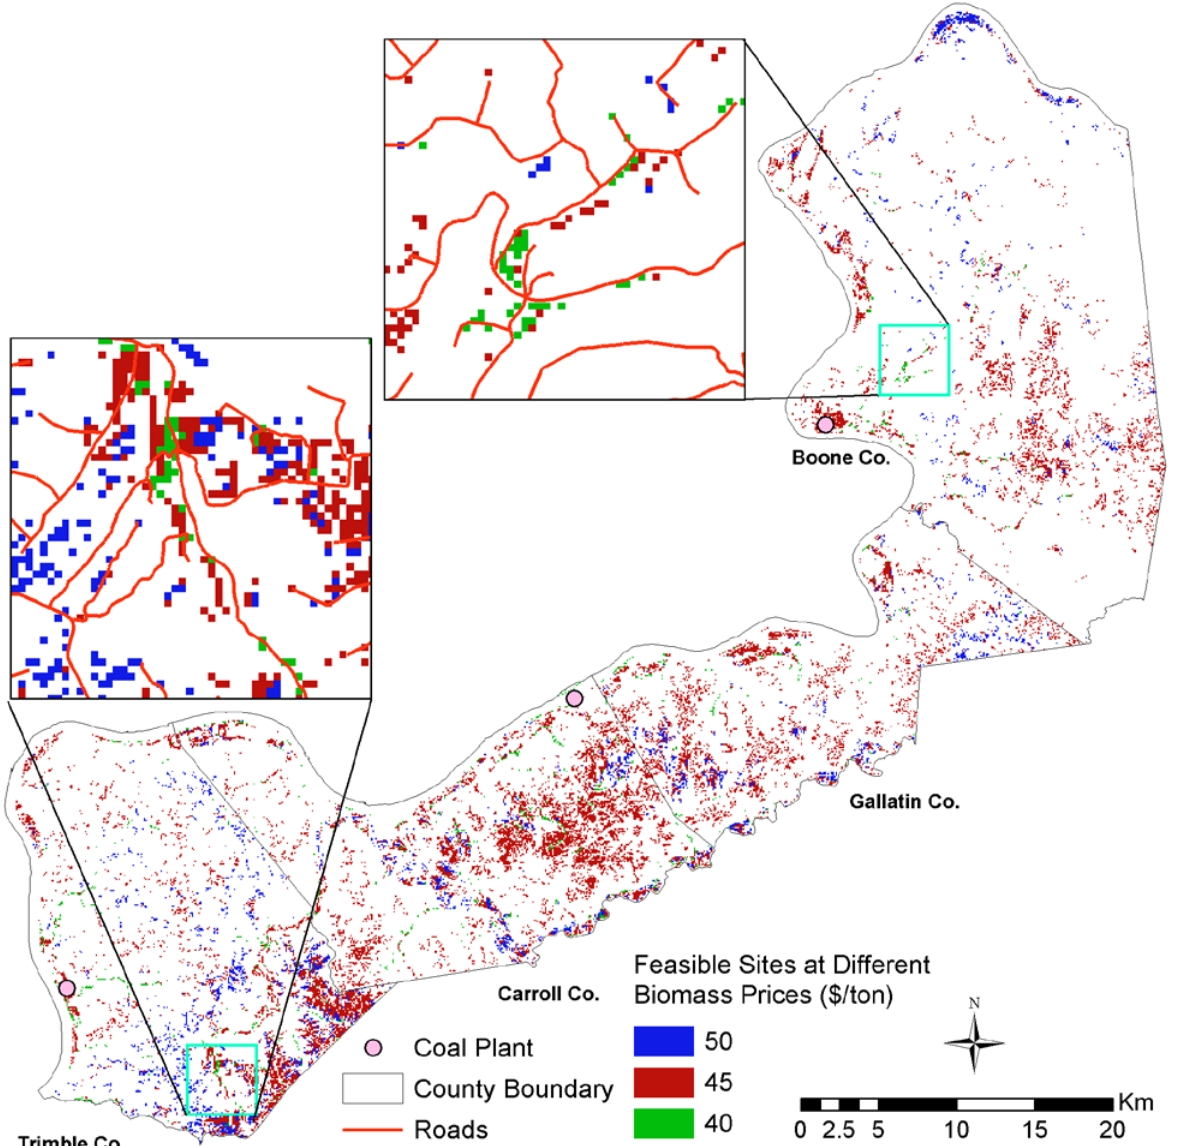
Figure 6. Spatial distribution of economically feasible sites for establishing sweetgum at different delivered biomass